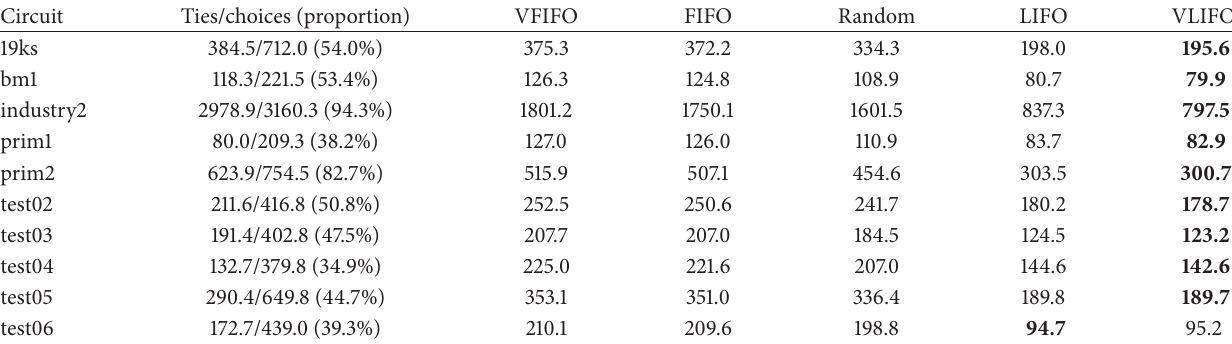
Table 2: Comparison of bipartition cut sizes (averaged over 1,000 runs).